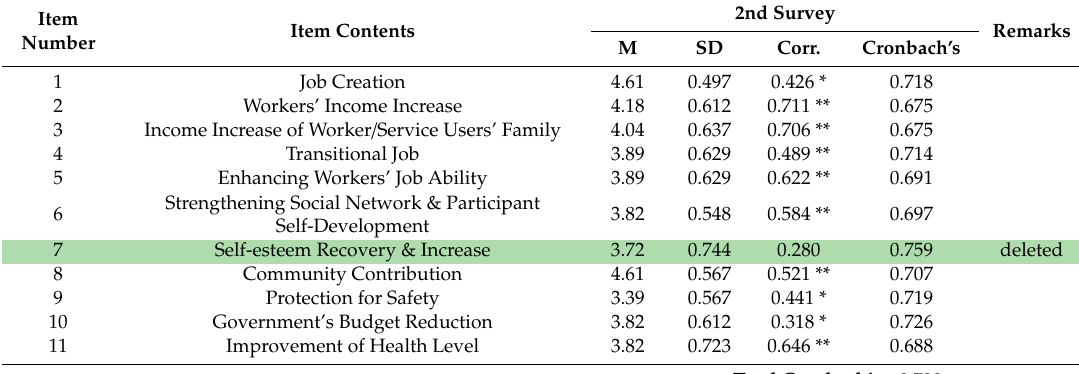
Table 2. Validity and Reliability of Social Value Domains in Social